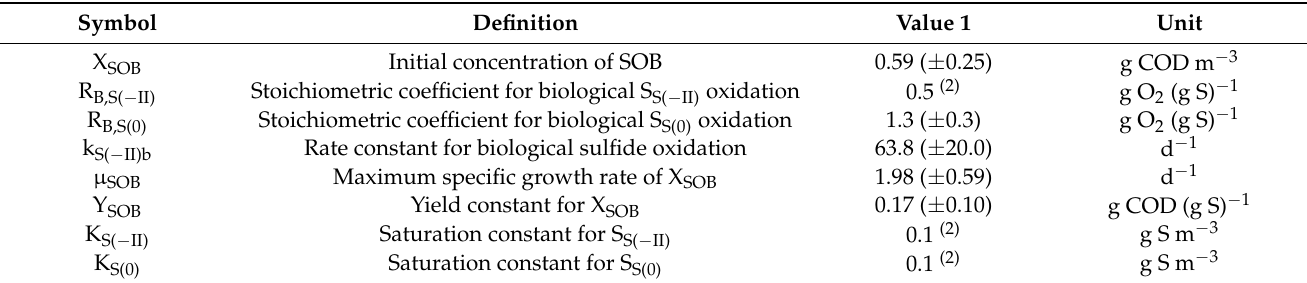
Table 3. Kinetic and stoichiometric parameter values for biological sulfide oxidation, determined by calibration of the model presented in Table 1. Symbol Definition Value 1 Unit Stoichiometric coefficient for biological S S( − II) oxidation Stoichiometric coefficient for biological S S(0)